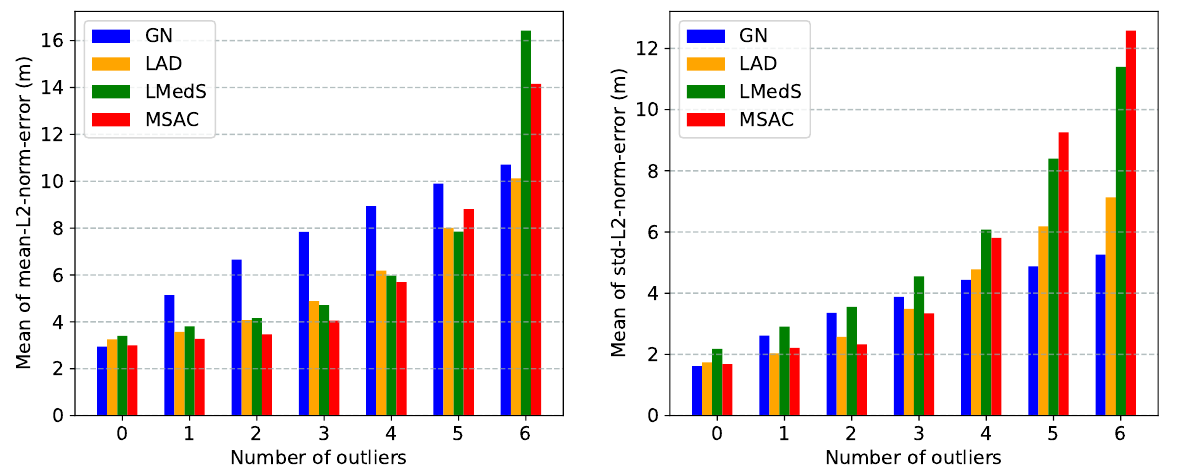
Figure 7. Simulation results for zero-mean i.i.d. Gaussian noise in the ToA measurements. First column show bias and second column show the variance . First row shows the result for σ = 1.0 ms and T = 120, and second row for σ = 1.0 ms and T = 35. Third row shows the result for σ = 2.0 ms. The outliers are chosen from an i.i.d. Uniform distribution in the interval [ − 30, − 10 ] (cid:83) [ 10,30 ]